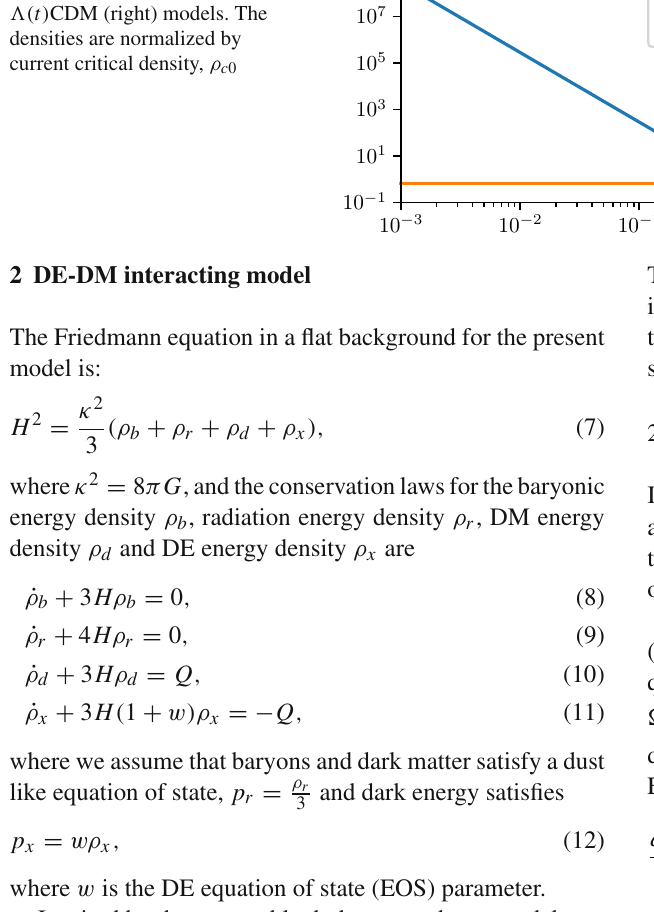
Fig. 1 Dark sector densities evolution for (cid:4) CDM (left) and (cid:4)( t ) CDM (right) models. The densities are normalized by current critical density, ρ c